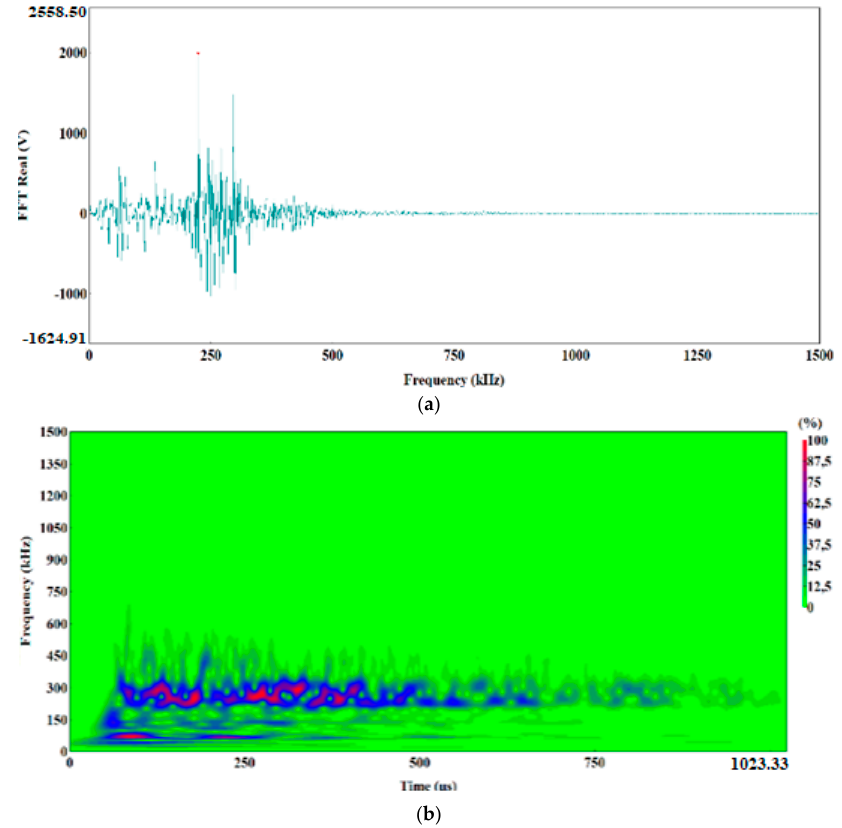
Figure 13. Waveform frequency domain (Real) ( a ) and waveform continuous wavelet (Morlet) ( b ) charts for the individual classes of AE signals (class 4).